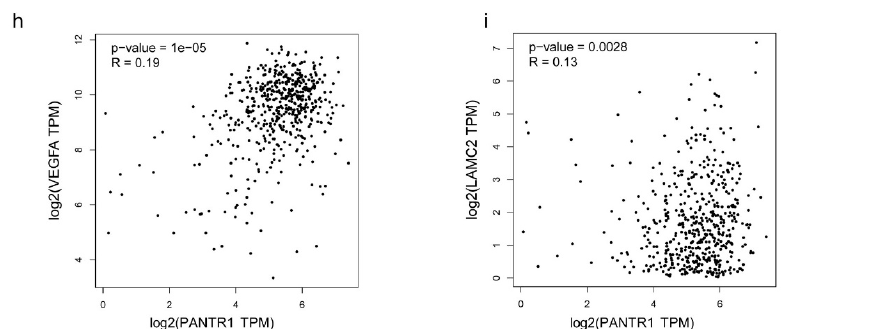
Figure 4. PANTR1 knock-down reduces endothelial tube formation, expression of angiogenic genes and endothelial cell migration. ( a – d ) Evaluation of key features of tube formation either under control conditions (negative control siRNA) or after PANTR1 knock-down; mean ± SD. ( e ) Corresponding representative pictures of tube formation assay. ( f ) Endothelial cell migration of HUVECS under control conditions (negative control siRNA) or after PANTR1 silencing; n = 3. Mean ± SD. * p < 0.05, ** p < 0.01, *** p < 0.001. ( g ) Quantification of mRNA levels of the angiogenesis-associated genes after PANTR1 knock-down in RCC-FG cells; n = 3. ( h ) Correlation analysis of PANTR1 and VEGF-A in ccRCC samples of the Cancer Genome Atlas. Data was derived from the publicly available gepia server. R = 0.19, p = 1.0 − 5 . ( i ) Correlation analysis of PANTR1 and LAMC2 in ccRCC samples of the Cancer Genome Atlas ( R = 0.13, p = 0.0028). Data was derived from the publicly available gepia